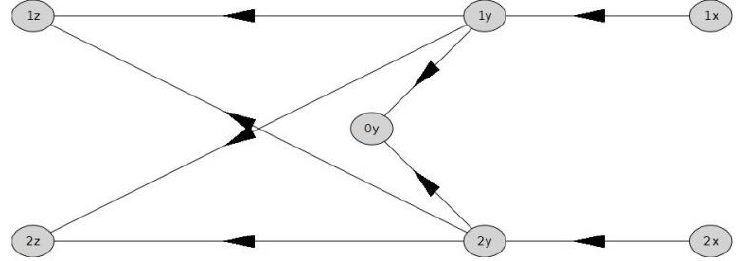
Figure 13. Graphical representation of a successful attempt to codify a scissors crossing.